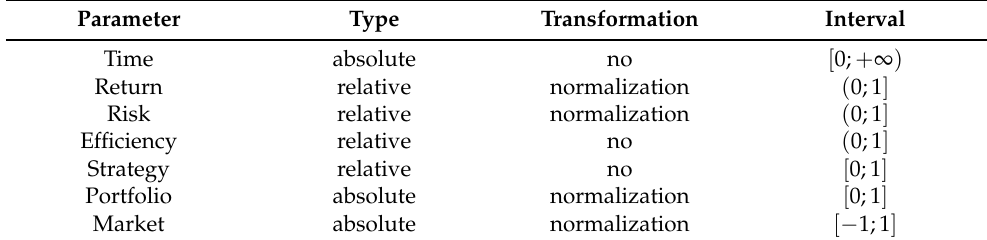
Table 2. Mathematical model scale